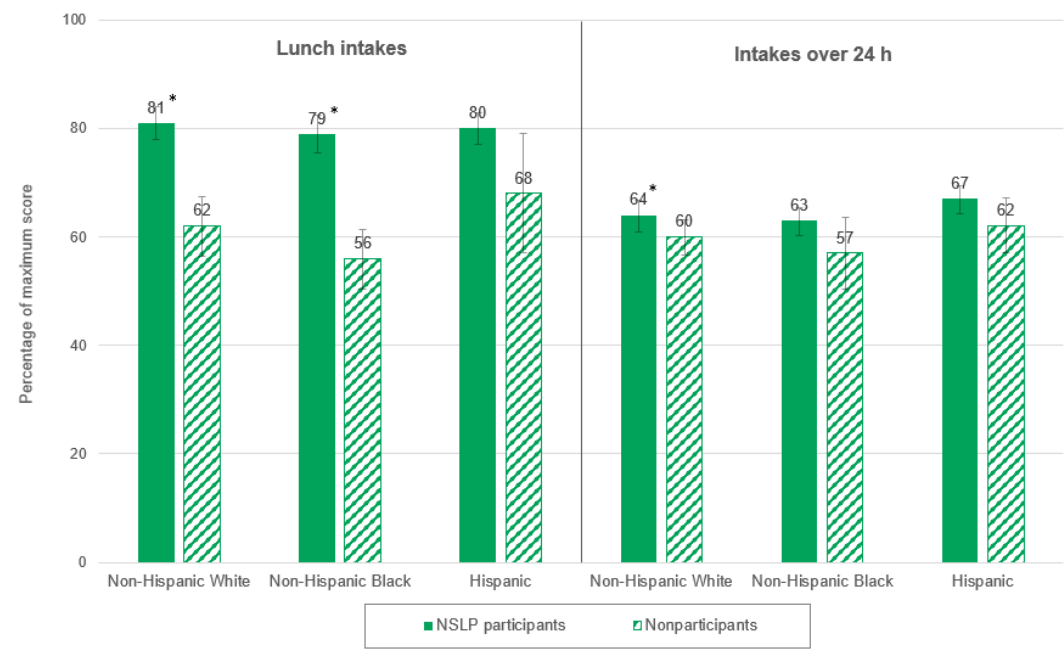
Figure 2. Differences between NSLP participants and nonparticipants in total HEI-2010 scores at lunch and over 24 h, by race/ethnicity. * Within a race/ethnicity subgroup, the difference between NSLP participants and nonparticipants was significantly different from zero at the p < 0.05 level. HEI = Healthy Eating Index; NSLP = National School Lunch Program.